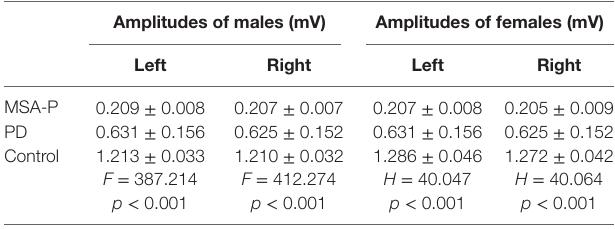
TaBle 3 | Comparison of the mean or median bulbocavernosus reflex amplitudes between multiple system atrophy with predominant parkinsonism (MSA-P), Parkinson’s disease (PD), and control groups.